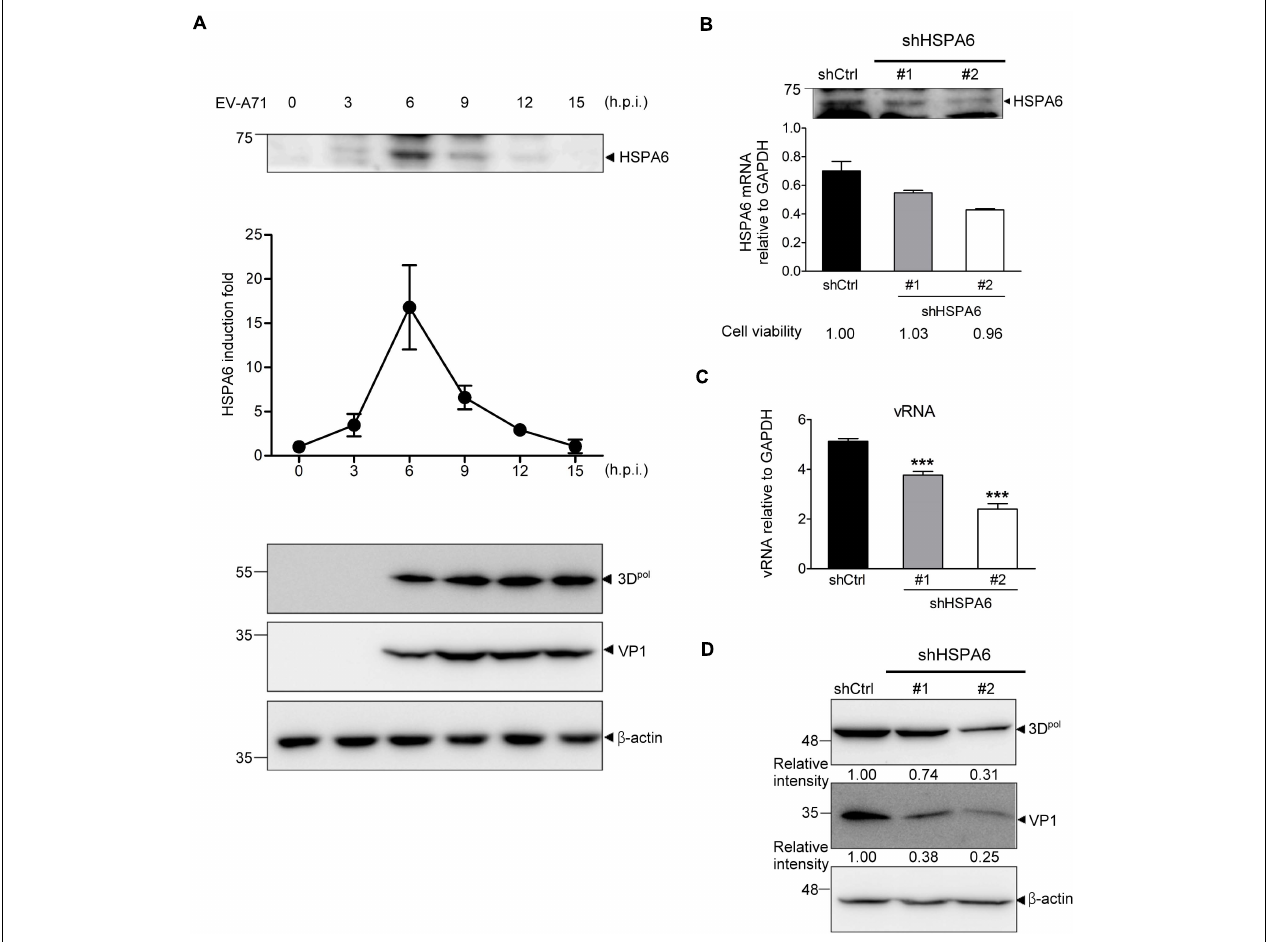
FIGURE 1 | HSPA6 is induced to support EV-A71 replication cycle. (A) RD cells were infected with EV-A71 (MOI = 5) and harvested for the protein expression of HSPA6 and viral 3D pol at the time points indicated. HSPA6 protein expression was quantitated from three independent experiments and presented as induction fold over 0 time point. (B–D) RD cells were infected with lentivirus expressing control shRNA (shCtrl) or shRNA specific to HSPA6 (shHSPA6 clone #1 and clone #2). 48 h later, the cells were infected with EV-A71 (MOI = 5) and harvested at 6 hpi for analyzing the productions of (B) HSPA6 mRNA, (C) cell-associated vRNA, and (D) viral proteins 3D pol and VP1. Cell viability of shHSPA6-treated cells was also indicated in (B) . HSPA6 mRNA and vRNA were measured by RT-qPCR and normalized with GAPDH mRNA. Protein production was examined by Western blot analysis using specific antibody indicated. RT-qPCR results were presented as means ± standard deviation (SD) ( n = 3). One-way ANOVA followed by Dunnett’s post hoc analysis was performed to compare the differences between the shCtrl group and the shHSPA6 groups in (C) . *** P <